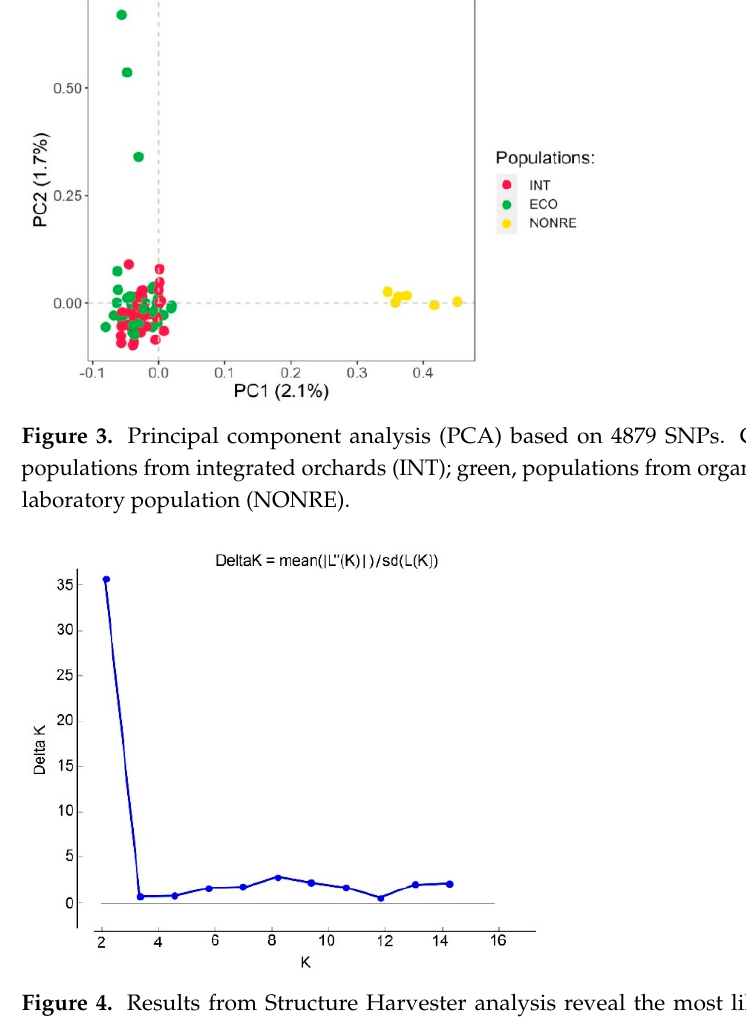
Figure 4. Results from Structure Harvester analysis reveal the most likely value of K based on STRUCTURE results.